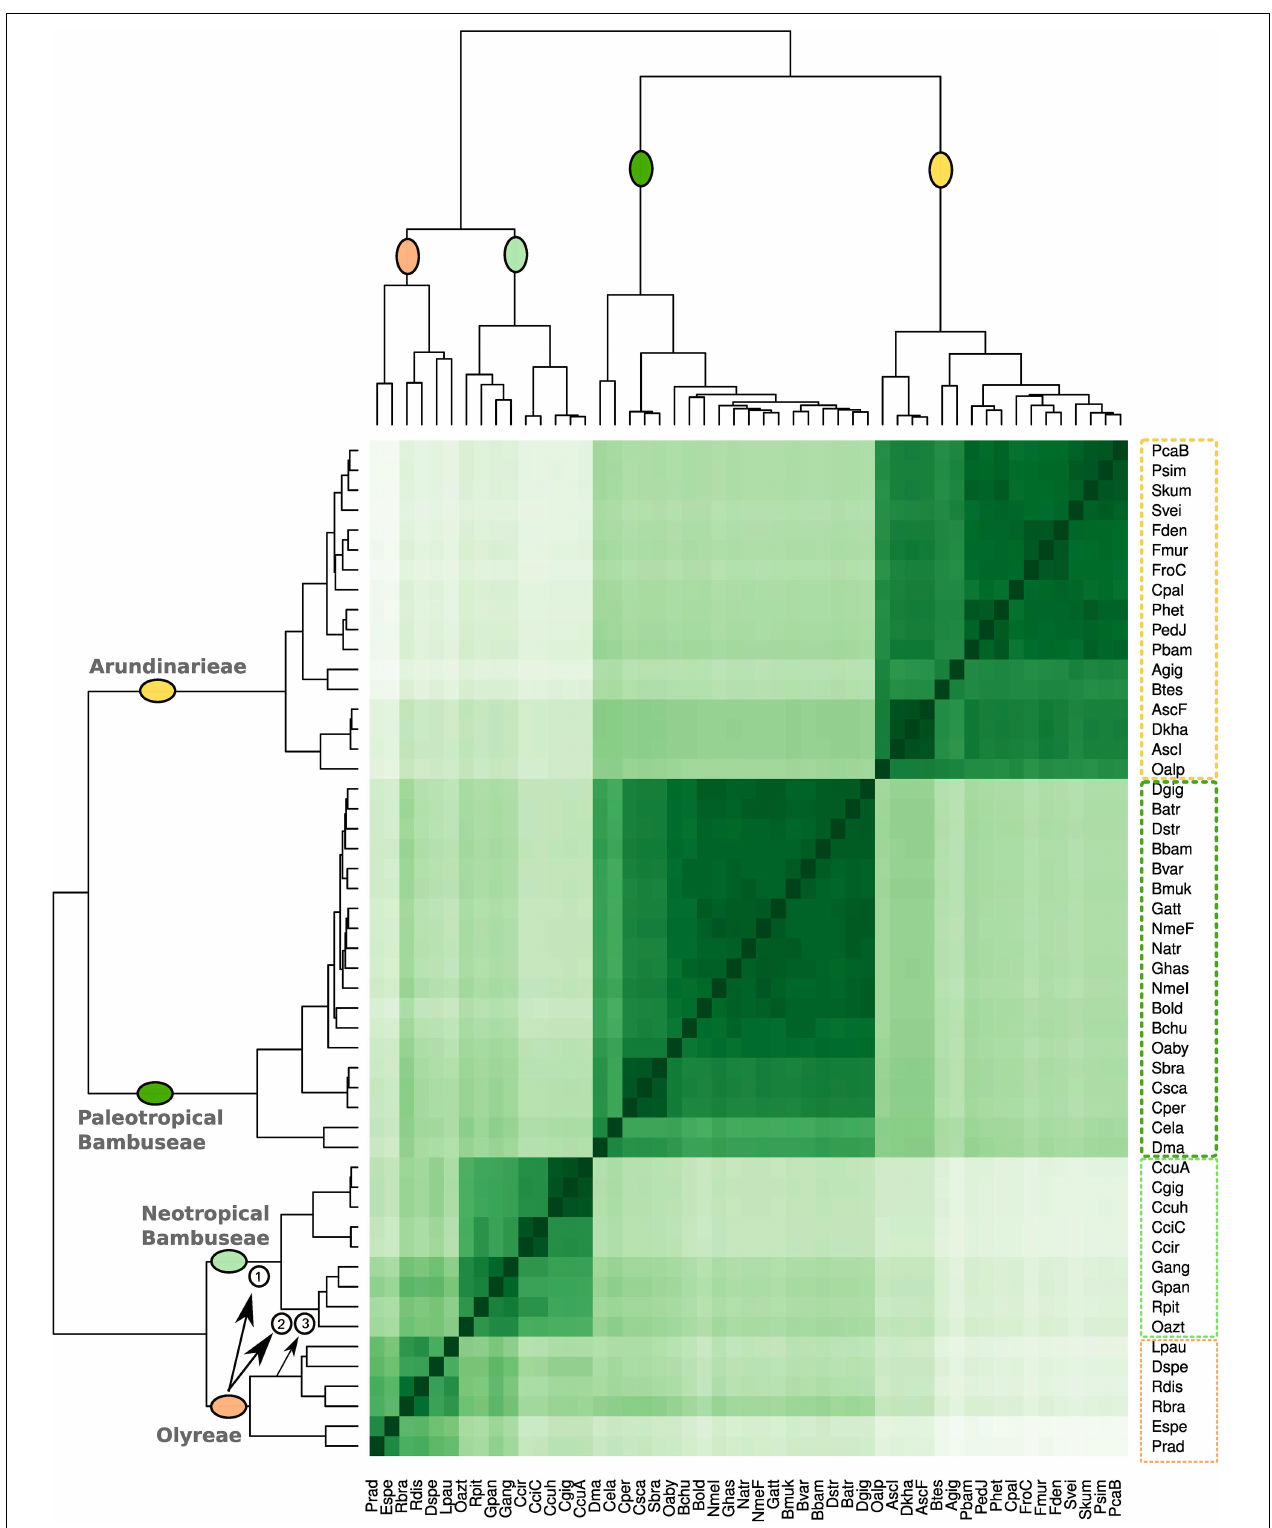
FIGURE 4 | Bamboo species similarity based on repeat diversity. The correlation matrix was built using the 365 most abundant repeat clusters using pheatmap R function. Upper and left sides represent the same phylogenetic relationship. Three proposed hybridization events between Olyreae and Neotropical woody bamboos are highlighted with the arrows and numbers. These events are then depicted in Figures 6A,B